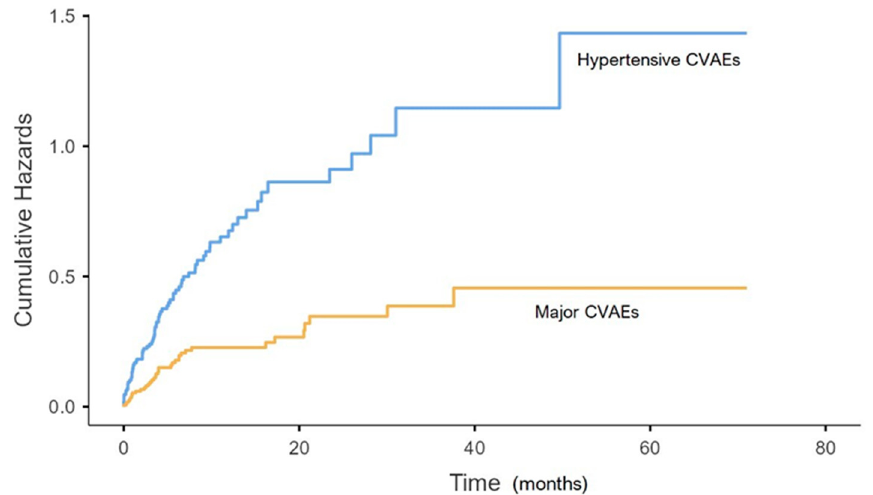
Figure 1. Kaplan–Meier curve of incidence of hypertension-related and major CVAEs. Arterial hypertension-related cardiovascular adverse events (CVAEs) are indicated in blue and major CVAEs in yellow. Patients with both hypertensive and major CVAEs are represented (with the proper onset time) in both curves.